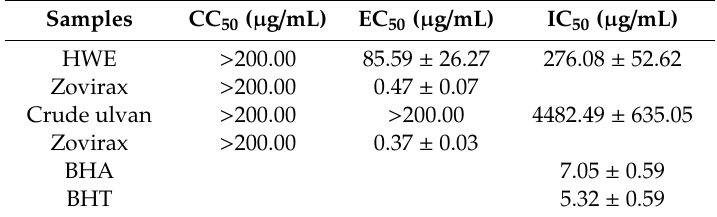
Table 8. Evaluation of cytotoxicity and antiviral and antioxidant activities of polysaccharide fractions.